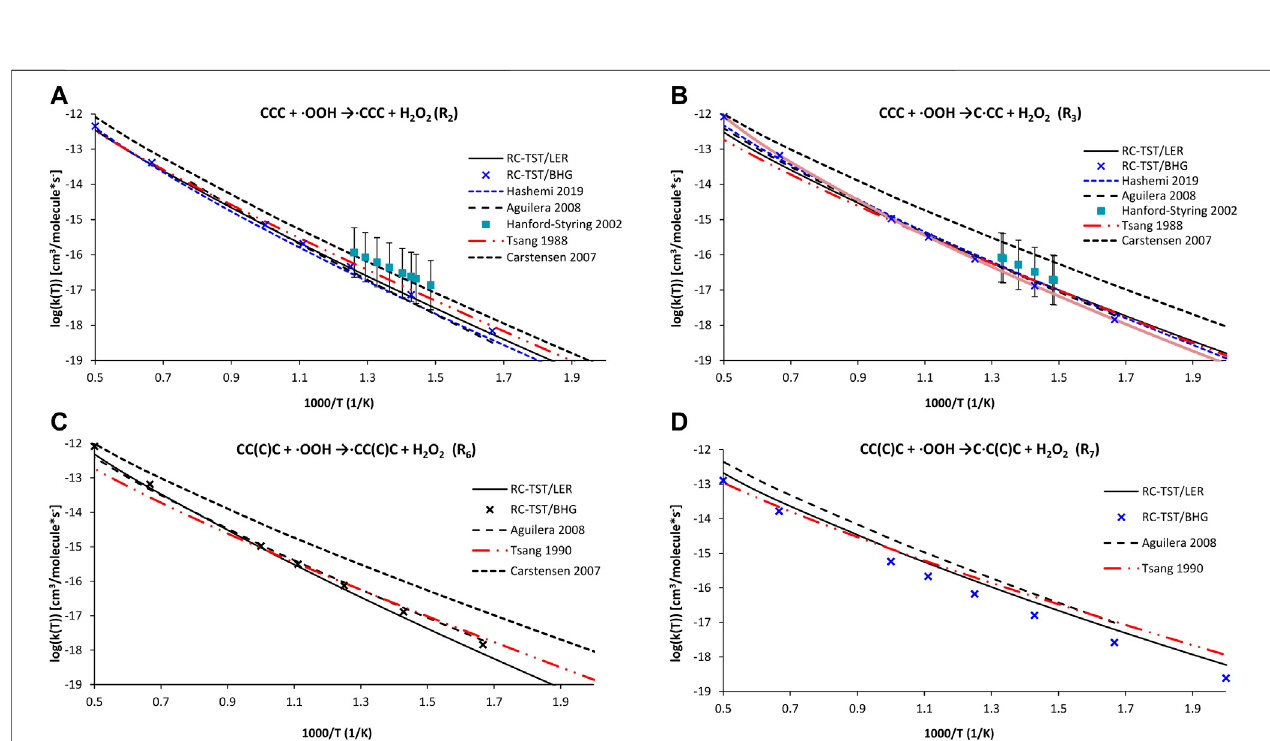
FIGURE9| ArrheniusplotsofthecomputedandliteraturerateconstantscalculatedwiththeRC-TST/LERandRC-TST/BHGapproachesforthe: (A) CH 3 CH 2 CH 3 + · OOH → · CH 2 CH 2 CH 3 + H 2 O 2 (reaction R 2 ); (B) CH 3 CH 2 CH 3 + OOH → CH 3 · CHCH 3 + H 2 O 2, ; (C) CH 3 CH(CH 3 )CH 3 + · OOH → · CH 2 CH(CH 3 )CH 3 + H 2 O 2 ; and (D) CH 3 CH(CH 3 )CH3 + · OOH → CH 3 · C(CH 3 )CH 3 + H 2 O 2 reactions. Electronic structure data were obtained at the M06-2X/aug-cc-pVTZ level.